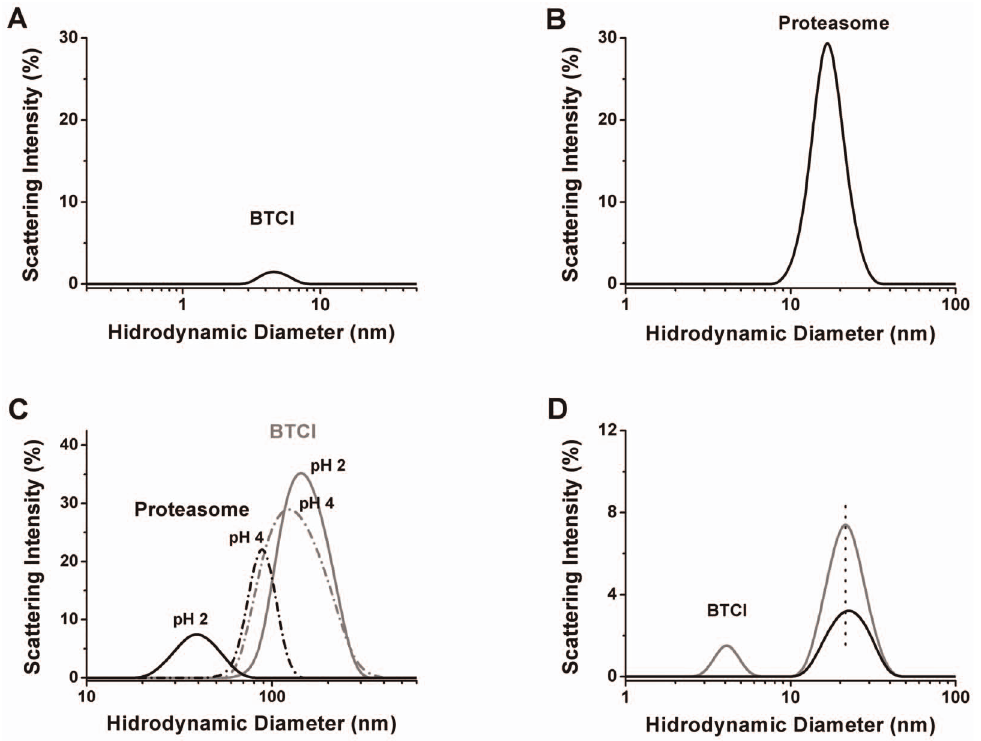
Figure 1. Dynamic Light Scattering size distribution of BTCI and the proteasome. Hydrodynamic diameter of BTCI as a trimer (15 m M; 25 kDa) and the 20S proteasome (21.4 nM; 505,2 kDa) as a monomer at neutral pH (A and B) and as aggregate in acidic condition (C) determined by Dynamic Light Scattering. The BTCI and BTCI-proteasome complex (in gray) were shown in panel (D). The conformational change of the complex (in black) was observed as indicated by differences in scattering intensity, polydispersity and hydrodynamic diameter (from 21.8 nm to 22.7 nm).